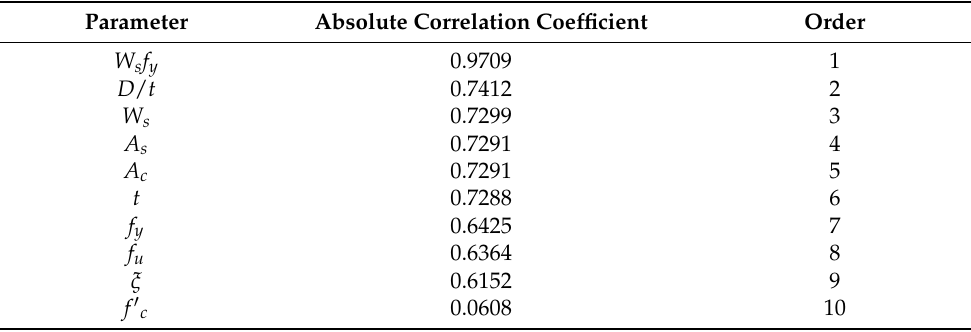
Table 3. Correlation between the nominal yield moment M y and parameters.